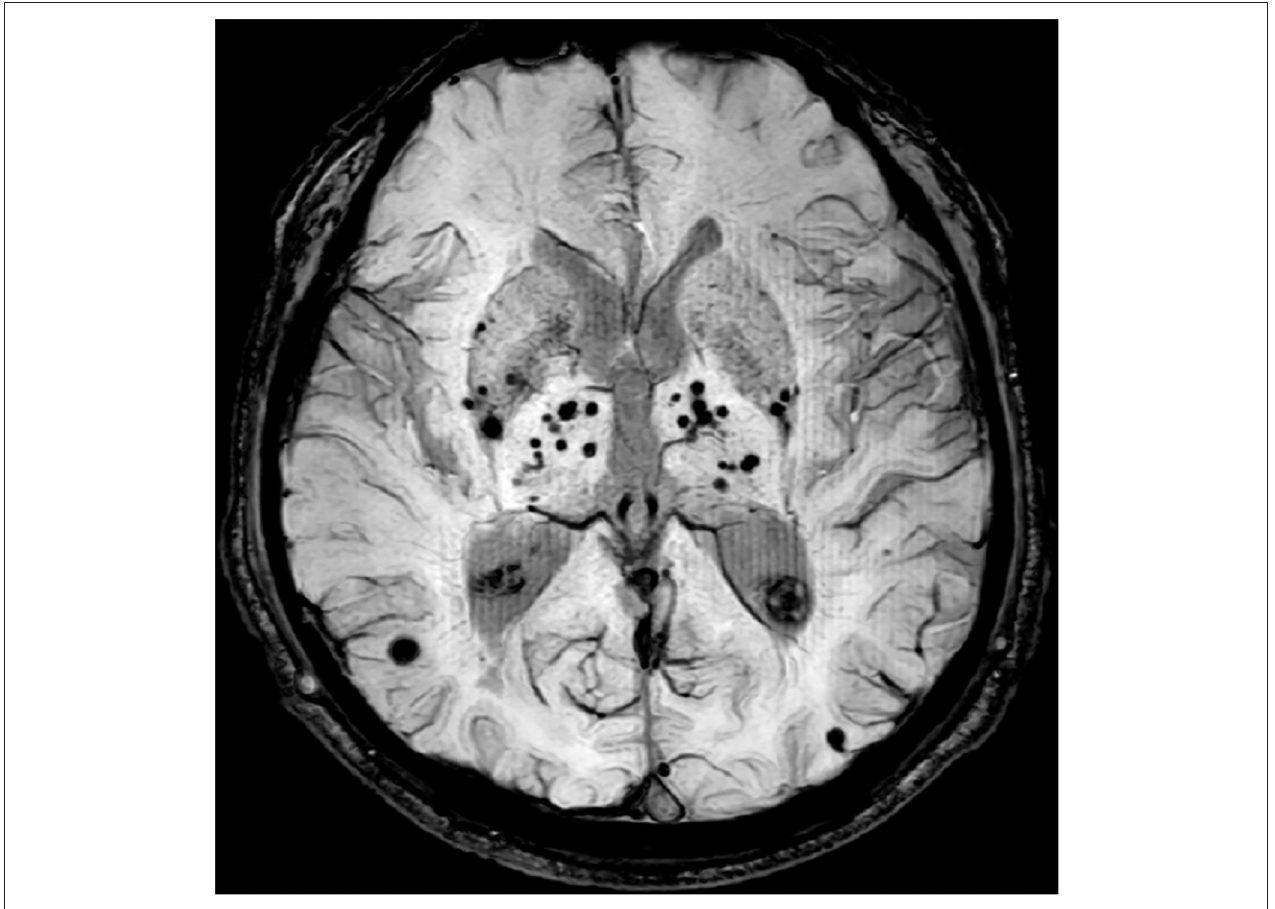
FIGURE 1 | CMBs lesions with different size in SWI image.